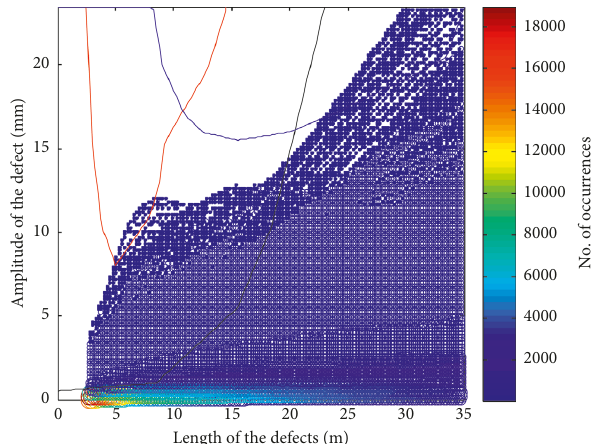
Figure 9: Overlay of the regions identified in Figure 7 with the scatter plot of the density of